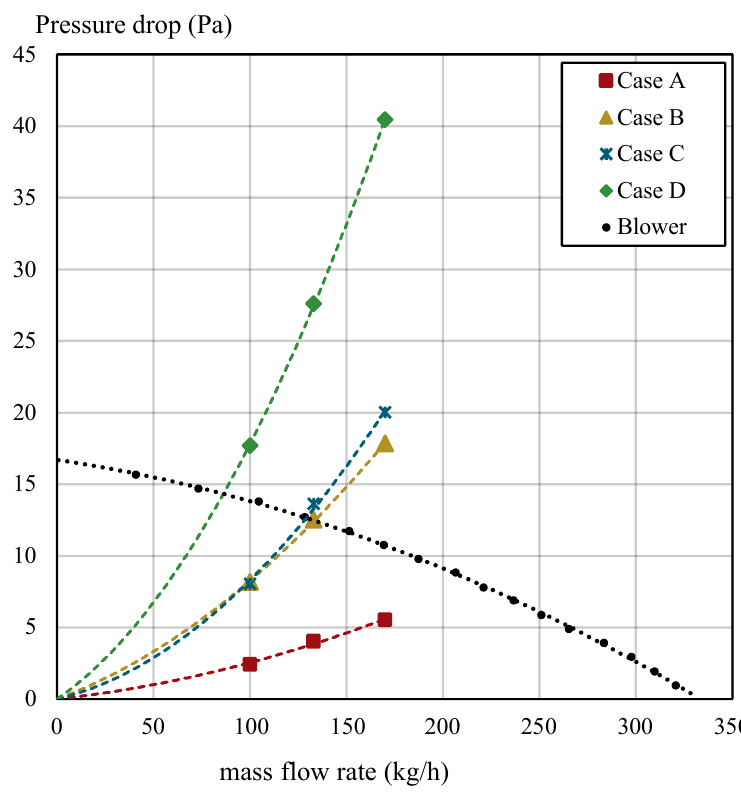
Figure 6. Blower curve and pressure losses caused by the different geometries of the heat exchangers analysed. Temperature of the hot gases